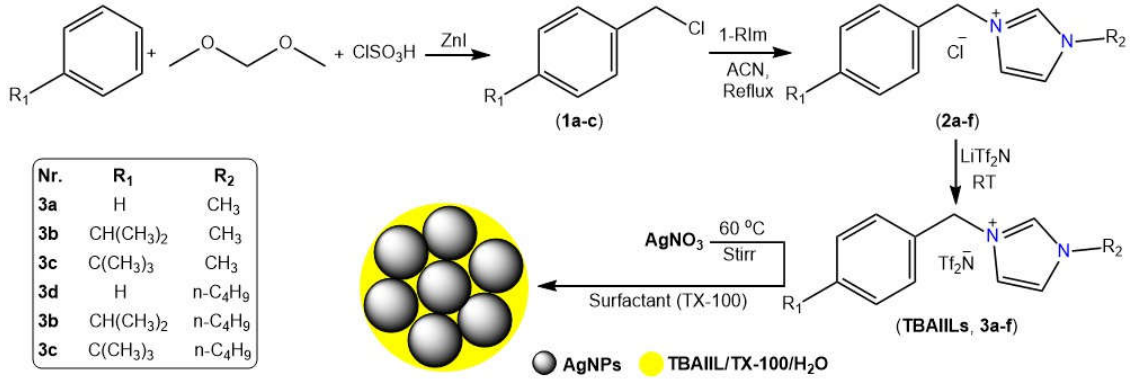
Figure 1 . Stepwise synthesis of BAIILs ( 3a-f ) their applications in the synthesis of AgNPs. Figure 1. Stepwise synthesis of BAIILs ( 3a–f ) their applications in the synthesis of